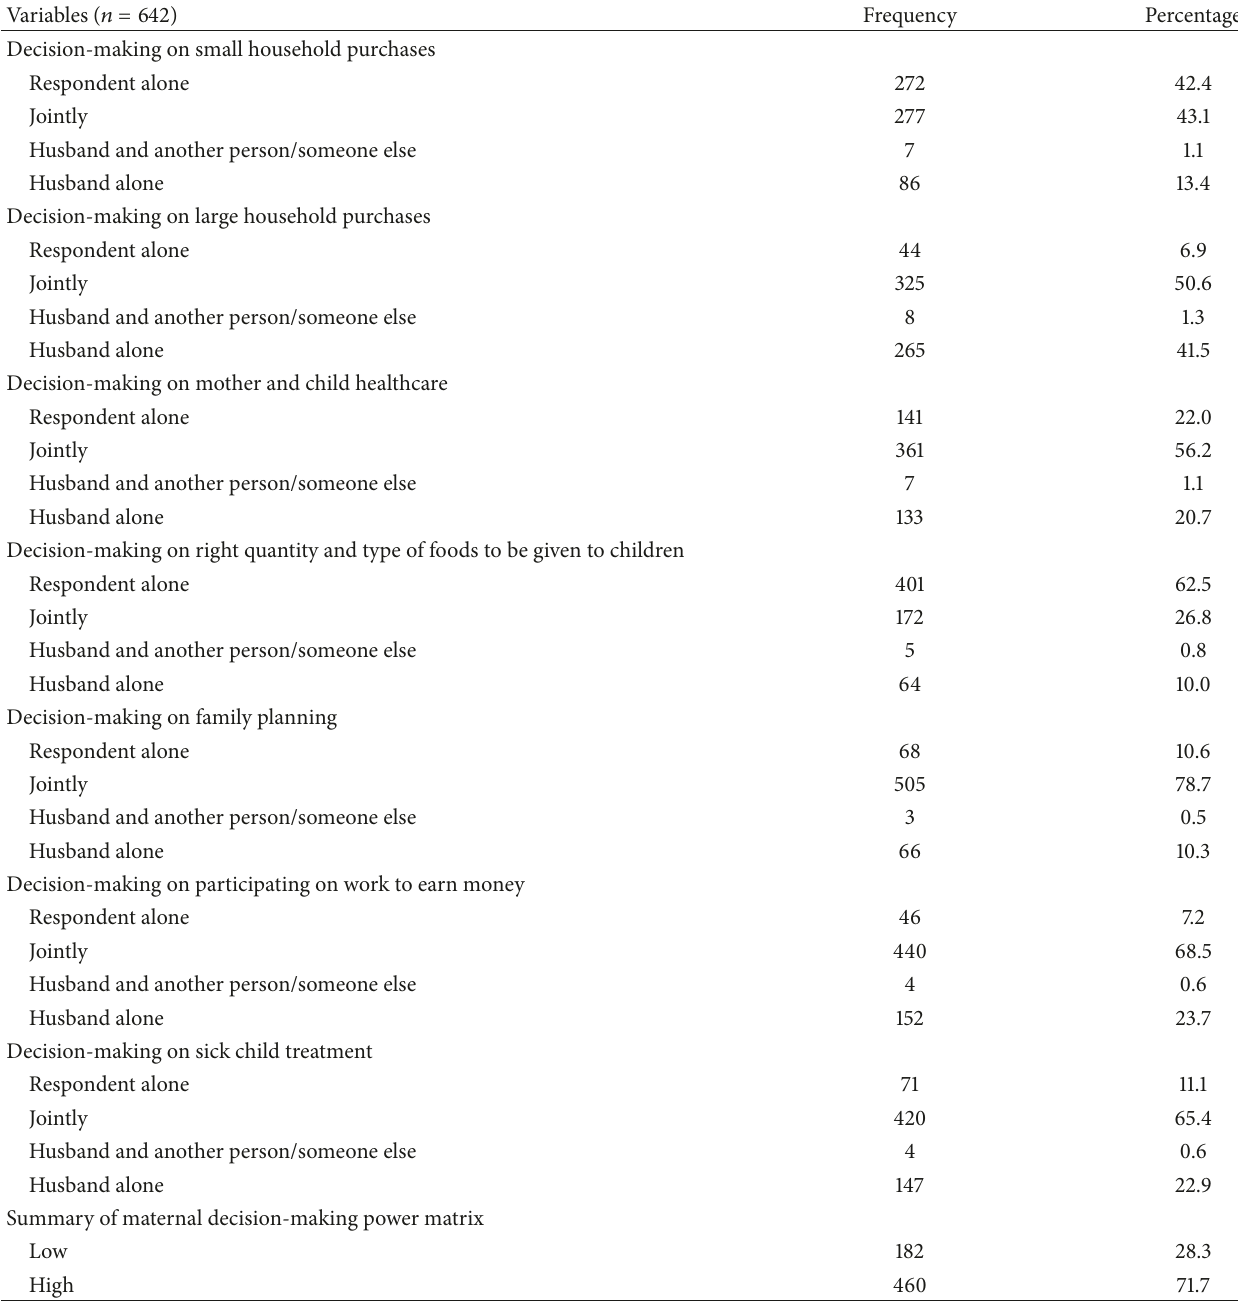
Table 3: Household decision-making autonomy of mothers in Wolaita Sodo town, southern Ethiopia,